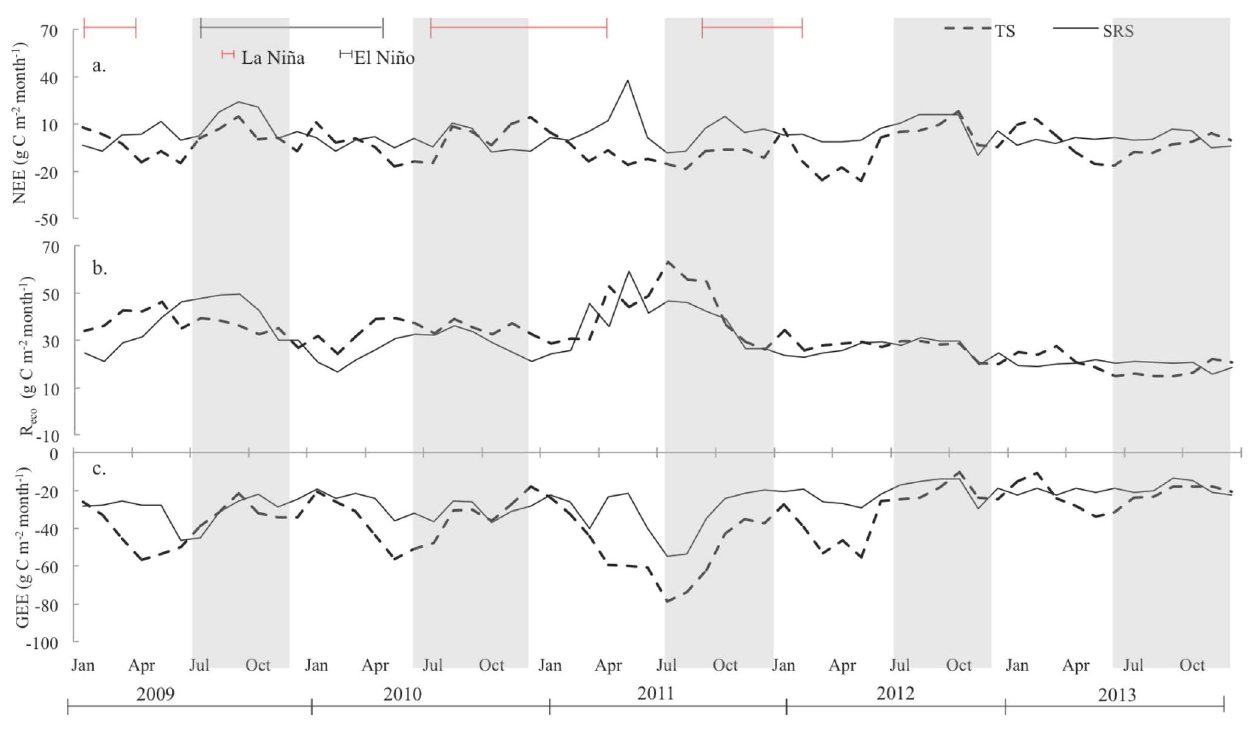
Fig. 5. Time series of monthly (a) NEE, (b) R eco and (c) GEE for TS and SRS. Variations in both ENSO phase and CO 2 exchange rates co-occurred with changes in wet and dry season